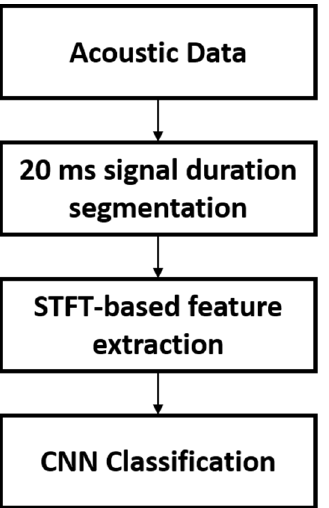
Figure 5. System overview of the method introduced in [39] .